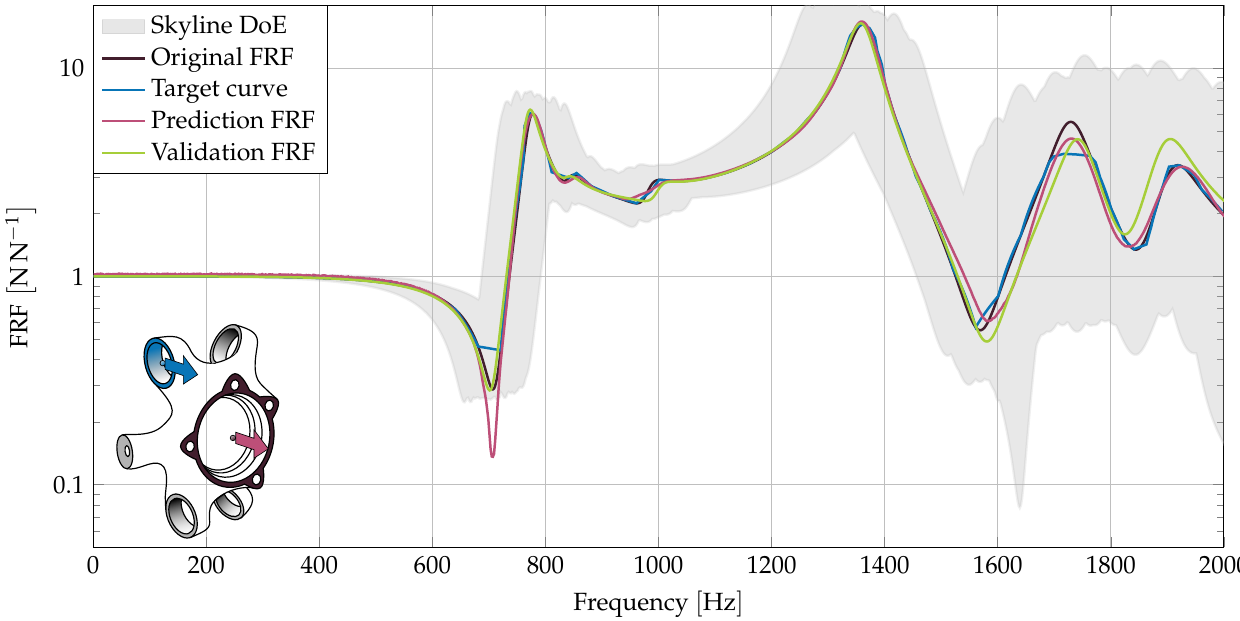
Figure 5. Optimization using a matching-curve for a desired amplitude reduction around